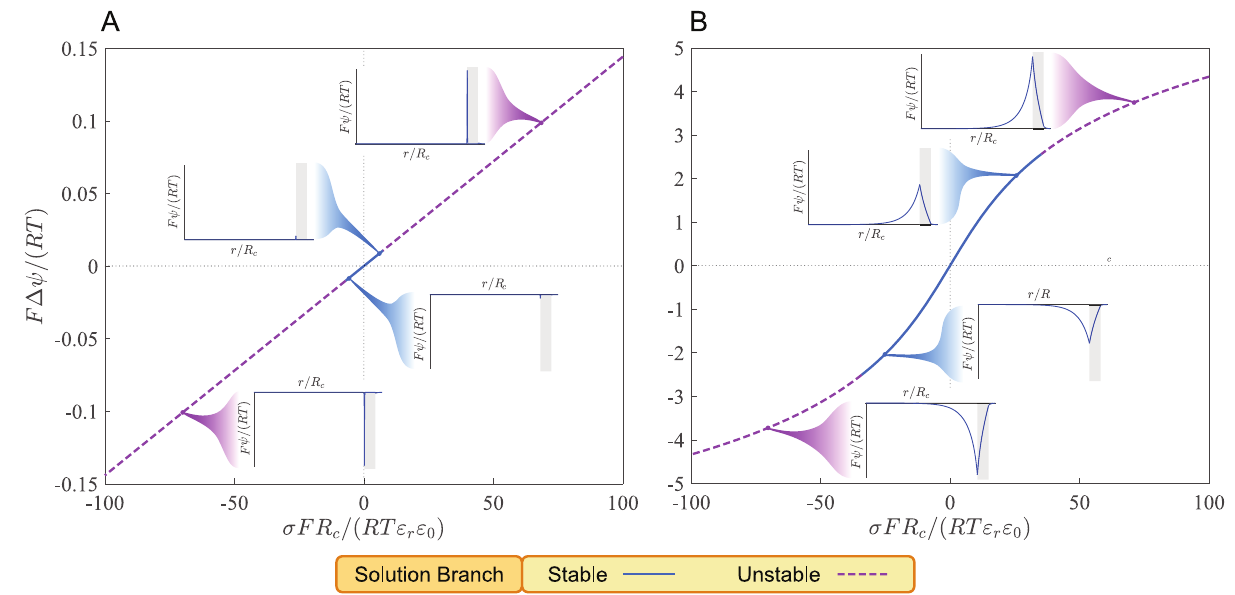
Fig 2. Steady-state solutions of the membrane potential Δ ψ parametrically represented with respect to the surface-charge density σ at C salt = 0.1 M and σ = 0.02. (A) R = 10 − 6 m and (B) R = 10 − 8 m. Inset figures show radial profile of the electric potential ψ at selected points along the steady-state r c c solution branches. Shaded areas indicate the position of the membrane along the r -axis. Stability analysis was performed for ϑ = 0.1. The tortuosity coefficient ϑ only affects stability without altering steady-state